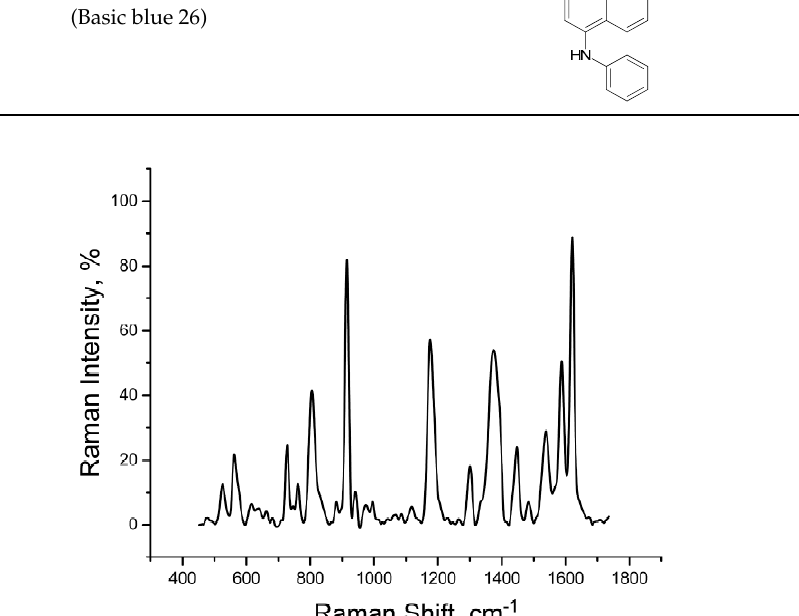
Figure 4. Raman spectra of writing ink based on triarylmethane dyes (B-type). This Raman spectrum was recorded at 532-nm excitation. Table 4. The frequencies and shapes of vibrations in Raman spectra recorded for writing ink containing dyes from the triarylmethane group (B-type) and data from the literature corresponding to crystal violet dye.